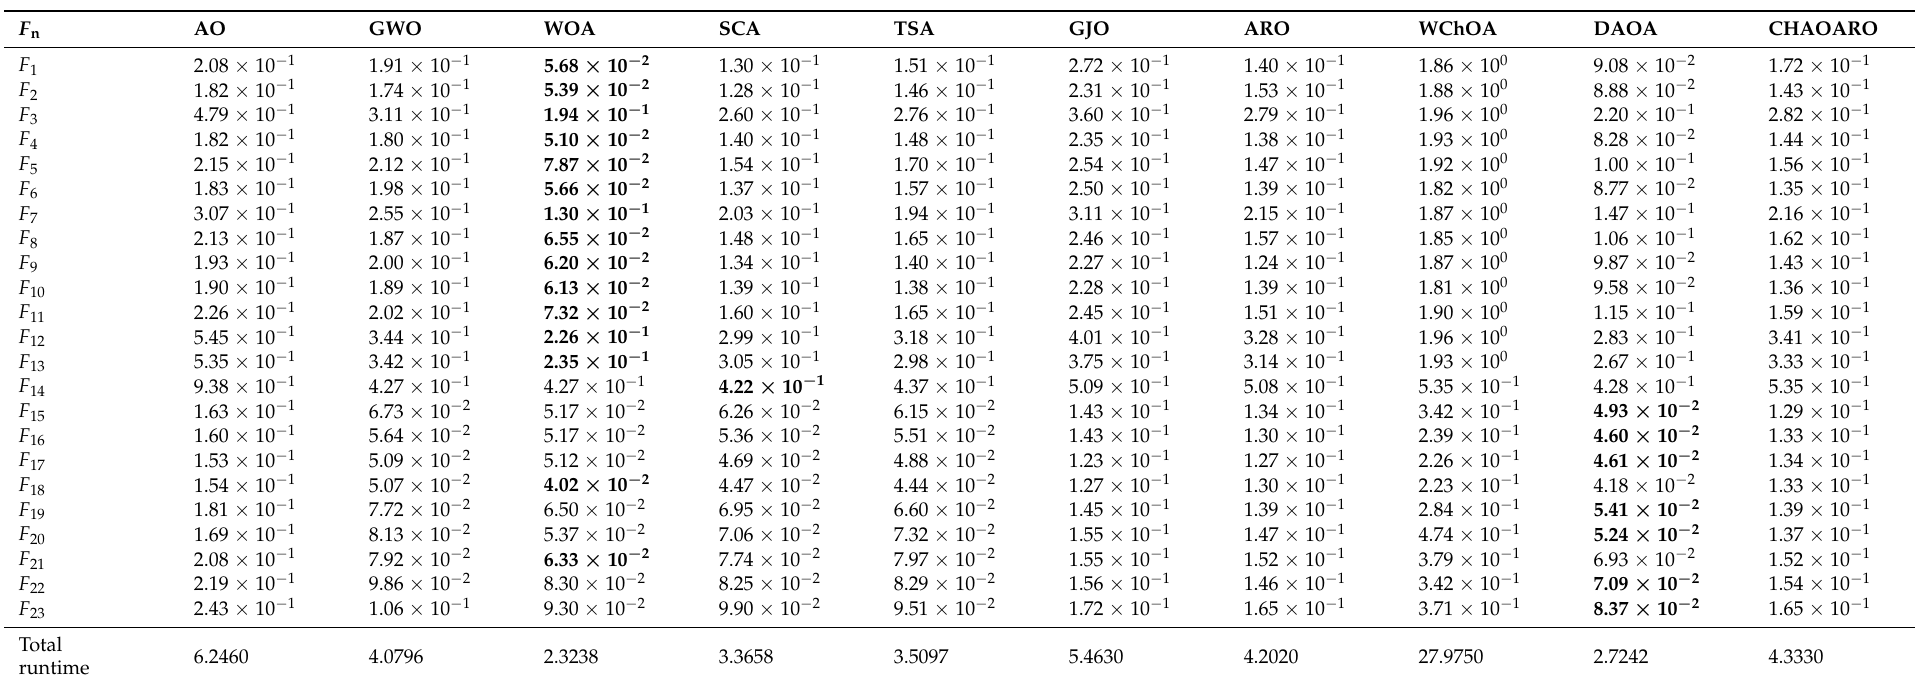
Table 8. Average computation time of CHAOARO and other algorithms on all benchmark functions (unit: